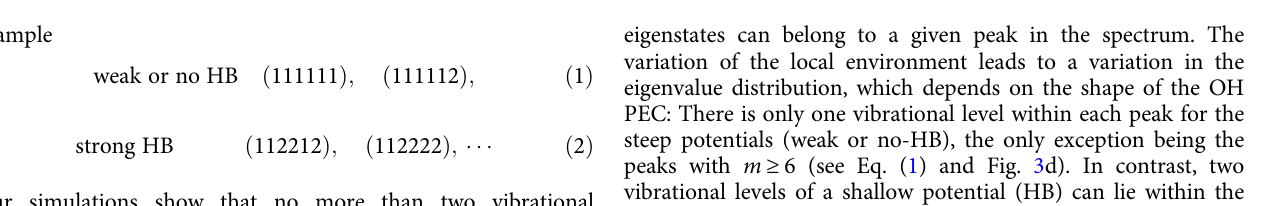
Our simulations show that no more than two vibrational